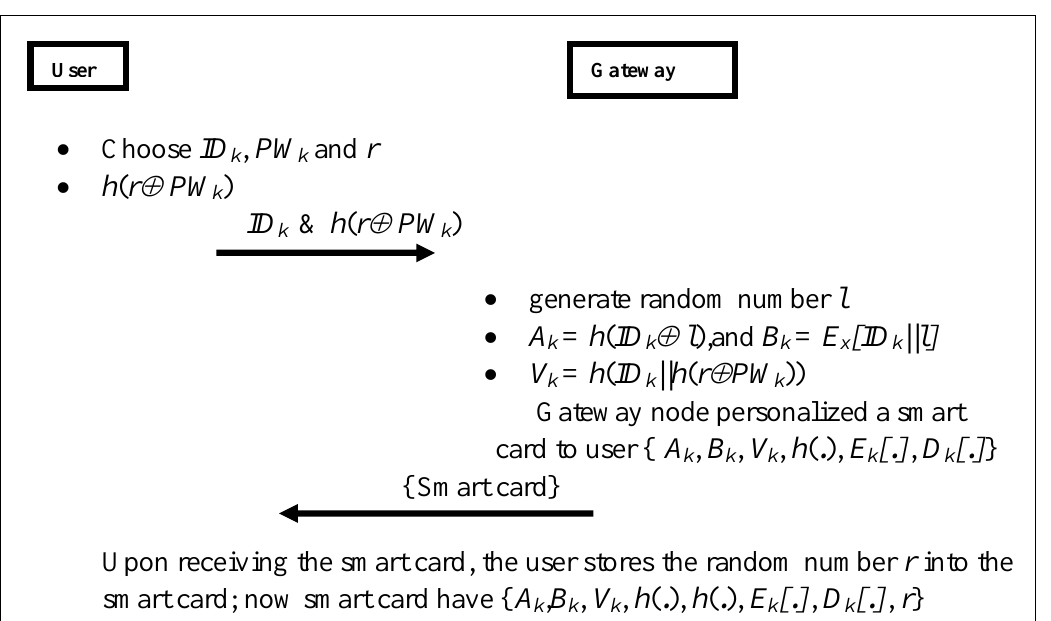
Figure 2. Flow of registration